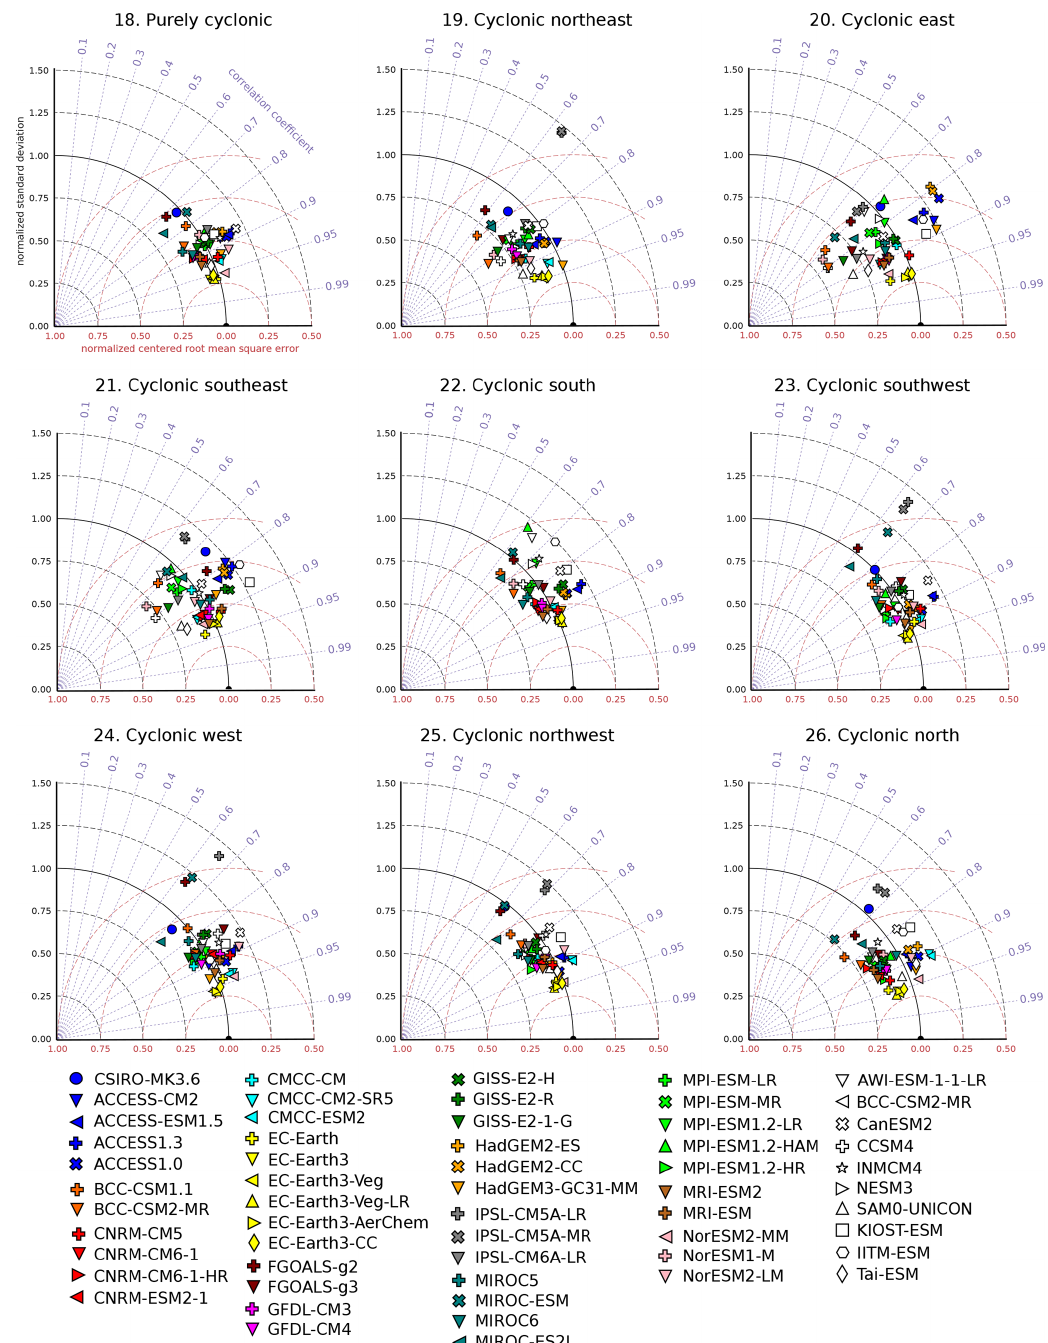
Figure 16. As Fig. 14 but for the nine cyclonic Lamb weather